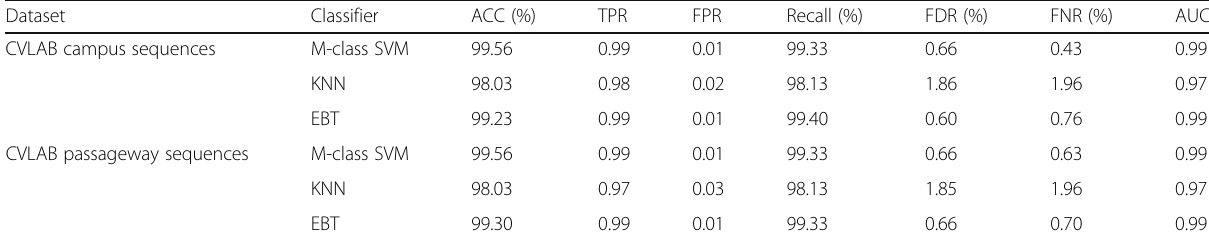
Table 2 Average results of proposed algorithm using EPFL dataset Dataset